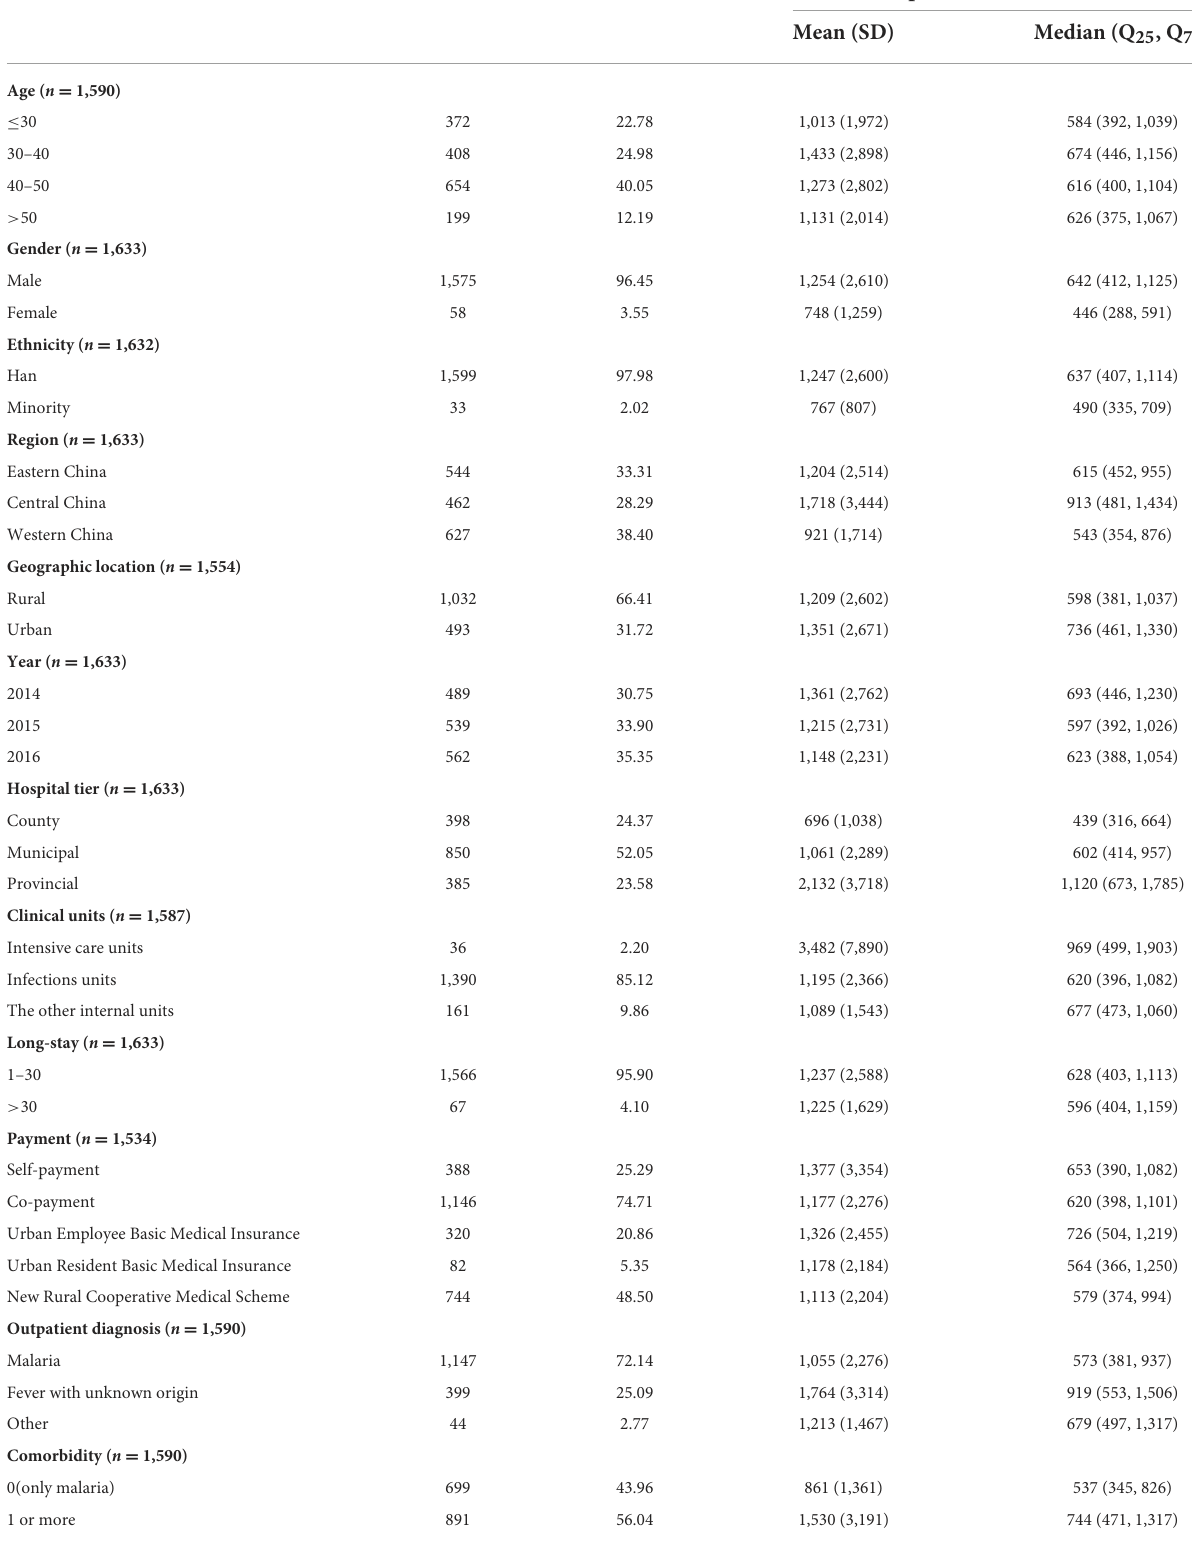
TABLE 2 Characteristics and hospitalization costs of malaria inpatients (USD).